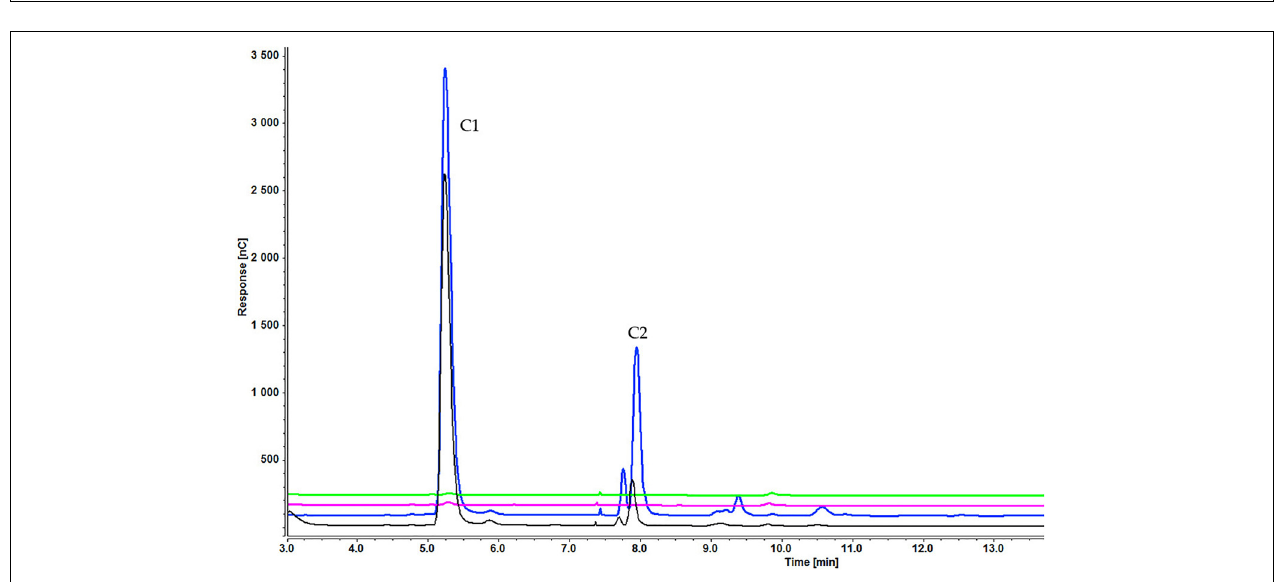
FIGURE 4 | Cellooligosaccharides concentration in the medium after 1 h (black), 3 h (blue), 5 h (pink), and 7 h (green) of induction with 0.3% cellobiose (C1 = glucose, C2 = cellobiose). Figures for 0.1% ( Supplementary Figure S1A ) and 0.2% cellobiose ( Supplementary Figure S1B ) is presented in Supplementary Material .